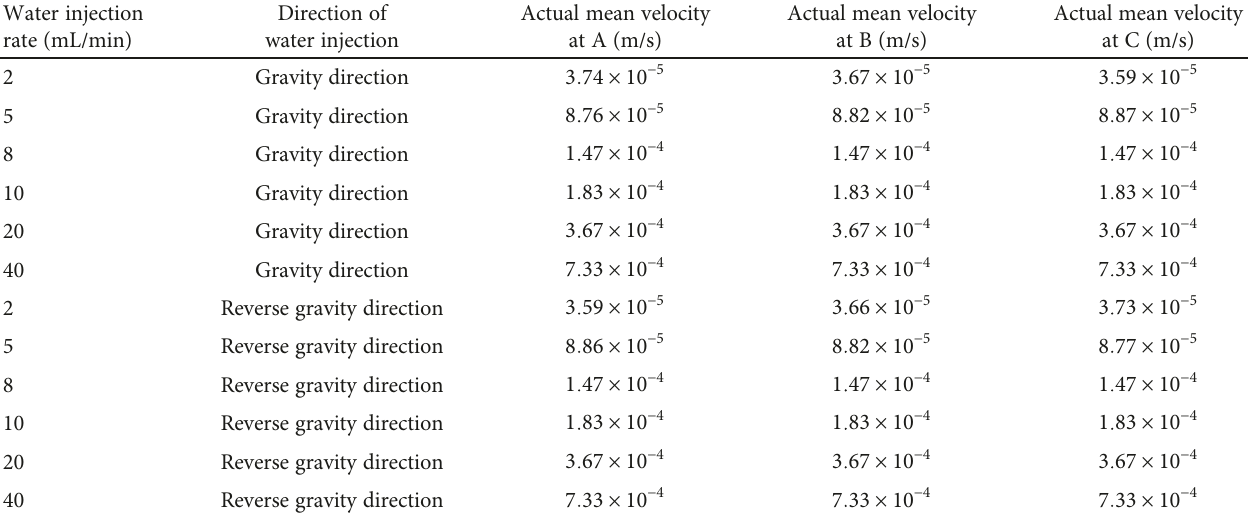
Table 4: Average actual velocity at A, B, and C holes in each